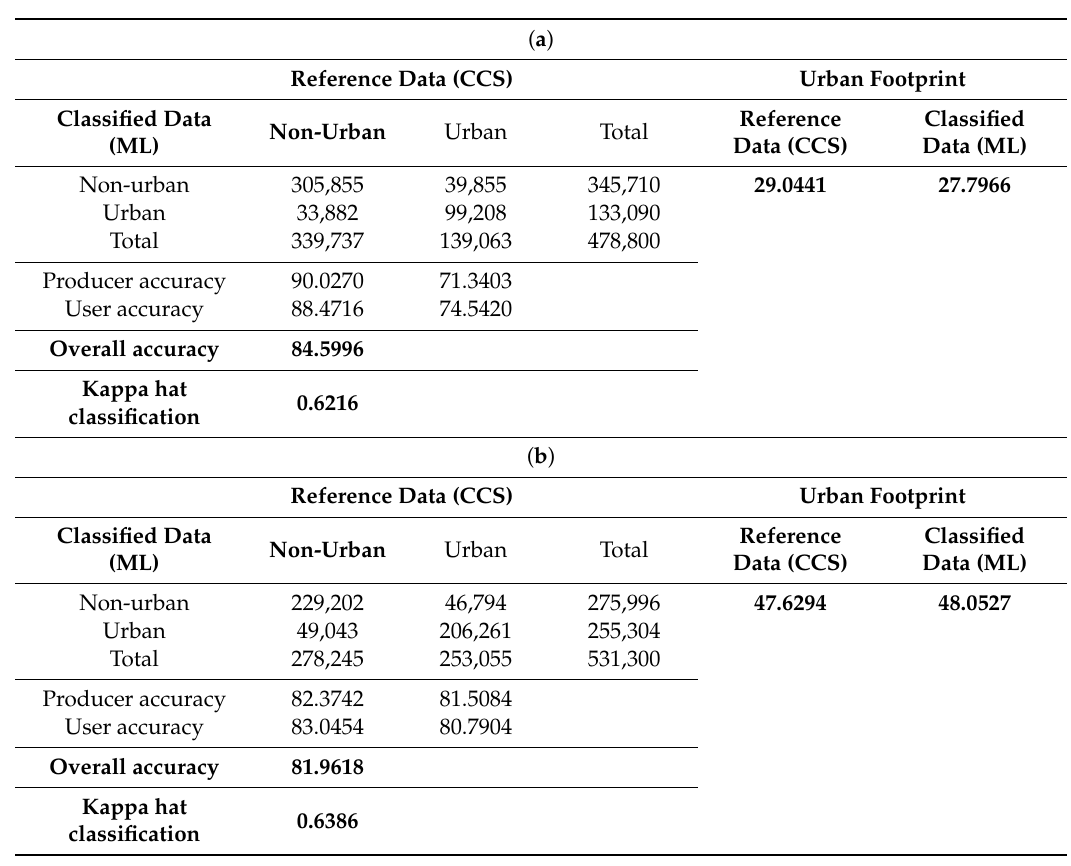
Figure 10. Supervised ML classification ( a ) and related accuracy assessments ( b ) performed on two restricted areas included within the main study area taken into account so far, using a series of coherence images that were processed from Sentinel-1A images (April 2019–July 2018). For a better visualization, in this image we omitted the Legend (see Figures 7–9). Table 6. Error matrix related to ML classification performed on the two restricted areas in the Venice region. Letters ( a ) and ( b ) are referred to the same letters in Figure 10.